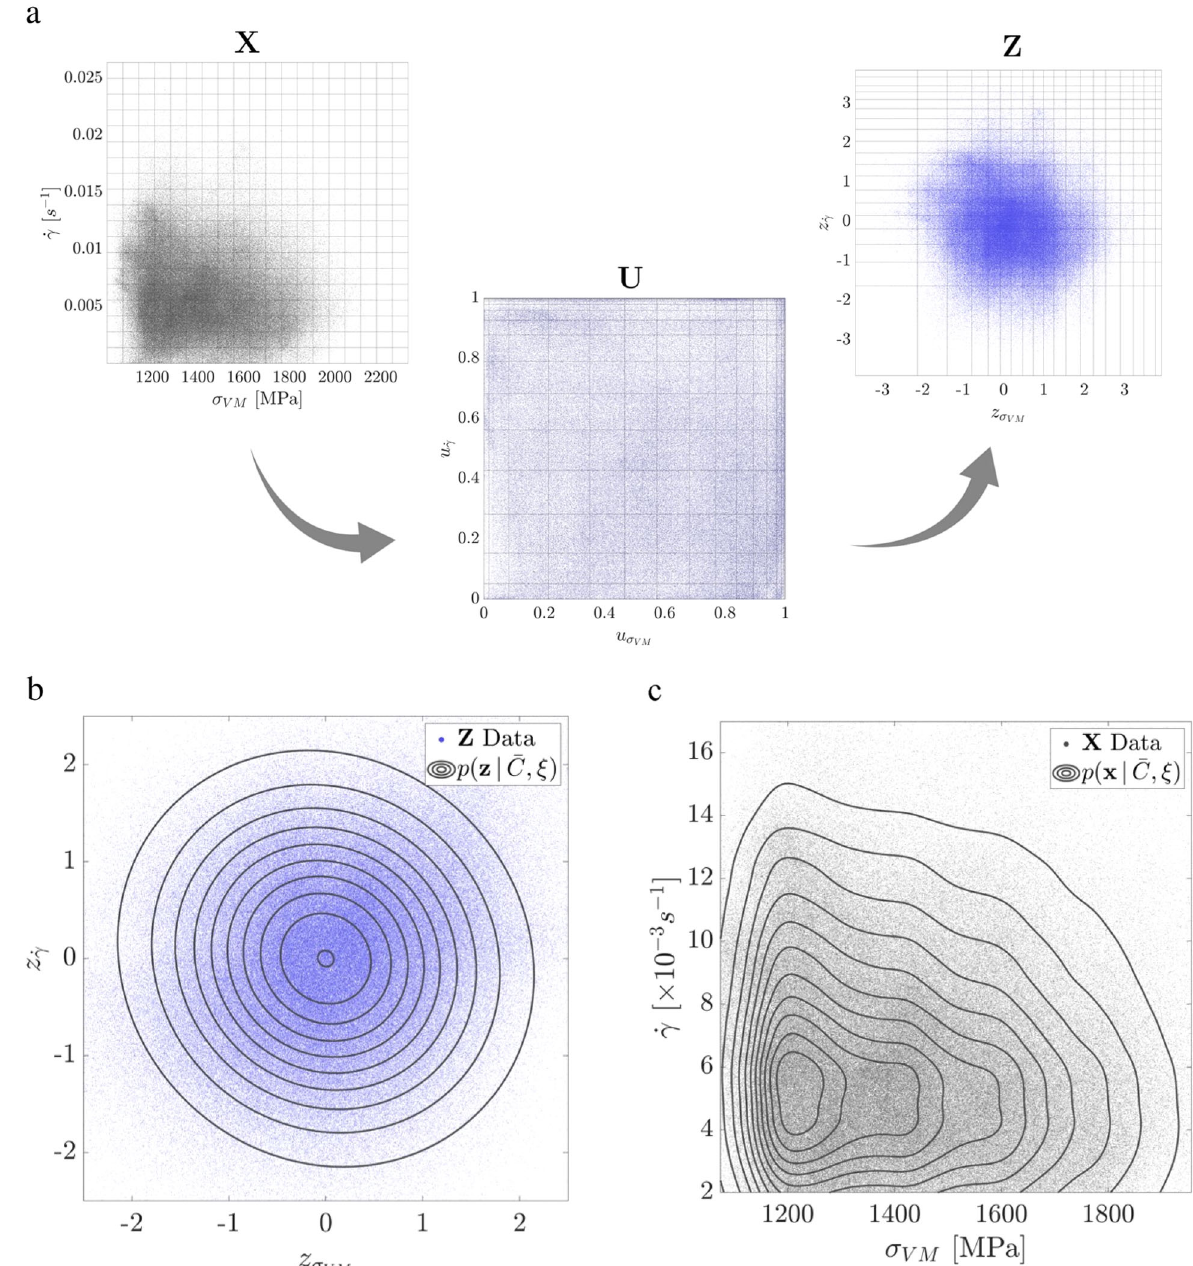
Fig. 8 Illustration of the Nataf transformation for two variables. a Example action of the Nataf transformation for the bivariate x ¼ ½ σ VM ; _ γ (cid:2) . Approximately 500,000 data points from all 12 microstructures are transformed from the observed X space to the marginally uniform U space to the standardized Z space. b Iso-probabilistic contours of the bivariate normal model fi t for the uncracked likelihood p ð z j C Þ in the bivariate example case of x ¼ ½ σ VM ; _ γ (cid:2) and c Iso-probabilistic contours of the model fi t for p ð z j C Þ by transforming the standardized model back to the X